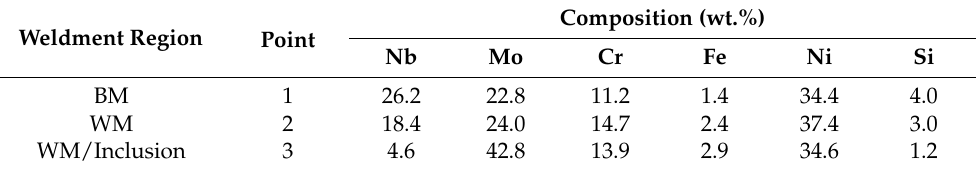
Figure 10. Pitting corrosion morphologies of the BM ( a , b ), WM ( c , d ) and WM/Inclusion ( e , f ) samples after potentiodynamic polarization in 0.6 M NaCl solution. Table 5. EDS chemical composition analyses of the regions highlighted in Figure 10.